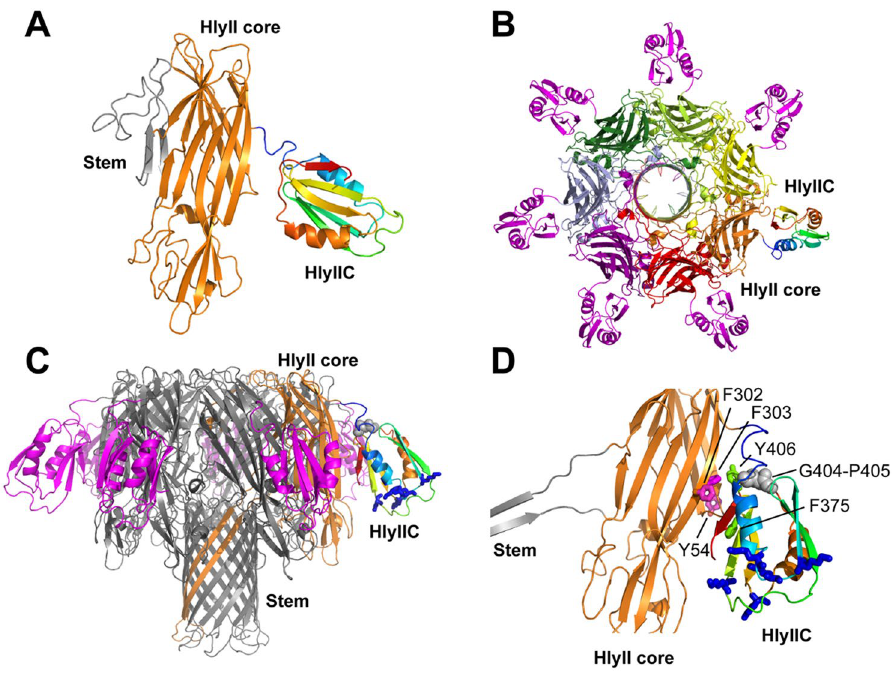
Figure 6. Modeling of full-length HlyII. ( A ) Model of the HlyII monomer based on the X-ray structure of monomeric S . aureus α -hemolysin (PDB code 4IDJ). The stem loop, which forms the trans-membrane β -barrel in the heptameric pore is colored gray, the core structure of HlyII in orange, and the HlyIIC domain in rainbow colors. ( B ) Model of the HlyII pore based on the X-ray structure of heptameric S . aureus α -hemolysin (PDB code 7AHL). The view is down the axis of the pore from the extracellular side, perpendicular to the plane of the membrane lipid bilayer. ( C ) View of the HlyII pore parallel to the plane of the lipid bilayer. The pore has a mushroom like structure, with the membrane-traversing β -barrel formed from the stem loops of seven monomers. The mushroom cap consists of the core domains. A protomer of the heptamer is colored in orange. In the model of the HlyII pore, the HlyIIC domain (shown in rainbow colors for one of the protomers) extends from the mushroom cap towards the membrane. ( D ) Expansion of the view in ( C ). The lysines that make up the positively charged patch of the HlyIIC domain are shown as blue sticks. The G404-P405 dipeptide, in a loop adjacent to the N-terminal connector, is depicted by gray spheres. Exposed aromatic residues that may dock the HlyIIC domain to the HlyII-core are labeled in the